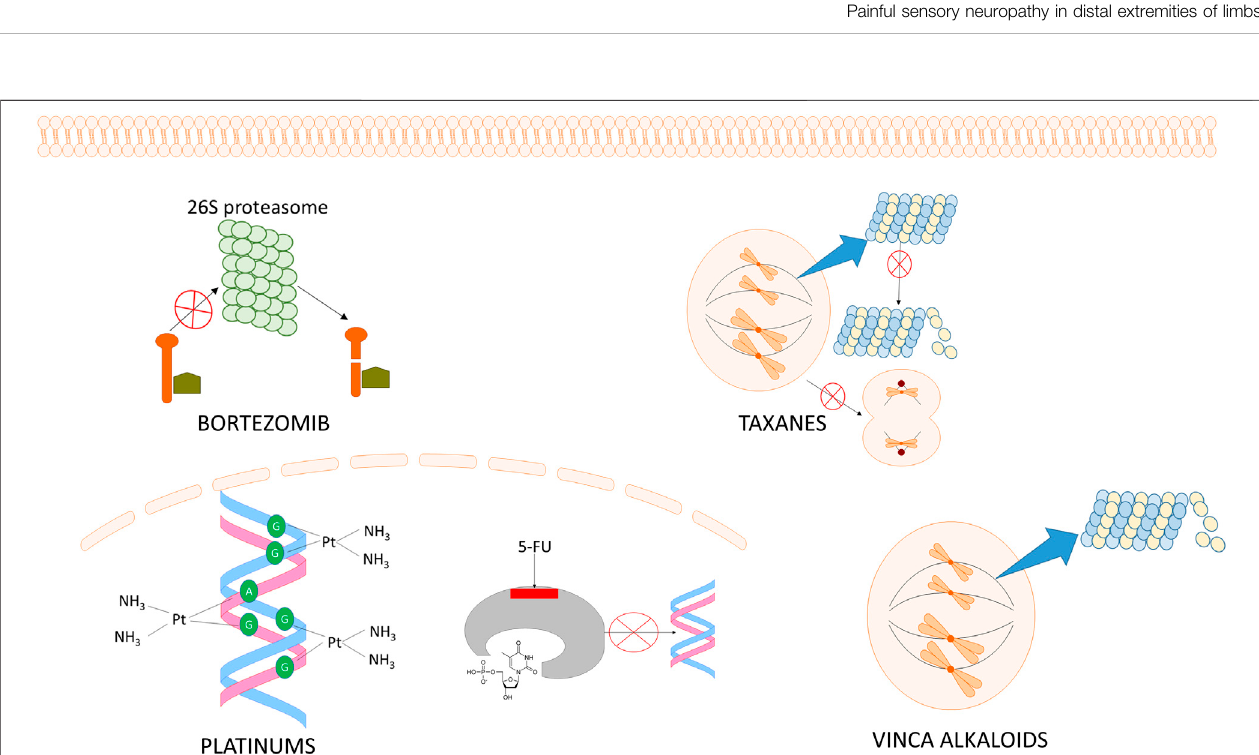
FIGURE 1 | Schematic representation of the mechanisms of action of the main antitumoral drugs that cause direct neurotoxicity and peripheral neuropathy. 1) Bortezomib inhibits the 26S proteasome. 2) Taxanes stabilize the tubulin proteins, therefore anaphase cannot be achieved. 3) Vinca alkaloids de-stabilize the microtubules, thus the mitotic spindle cannot be formed. 4) Platinum-based compounds form intra-strand and cross-strand links. 5) 5- Fluorouracil (5-FU) binds to thymidylate synthase (TS). Both platinum-based compounds and 5-FU inhibit DNA synthesis.